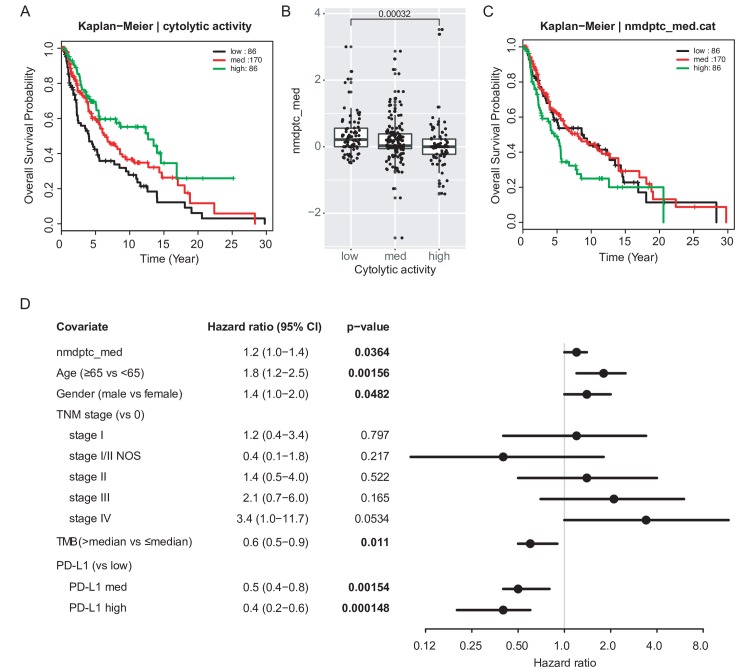
Cytolytic activity and NMD burden stratifies overall survival outcomes.(A) Kaplan-Meier overall survival for SKCM, stratified by cytolytic activity (categorized into low, med, and high based on quartiles). Legend shows the number of patients in each cytolytic activity level. (B) Association of feature nmdptc_med (NMD burden based on nonsense and frameshift, calculated based on median) on cytolytic activity. Statistical significance was determined using Mann-Whitney test. (C) Kaplan-Meier overall survival for SKCM, stratified by nmdptc_med (categorized into low, med, and high based on quartiles). (D) Forest plot of hazard ratios of each variable, in a multivariate Cox regression model for NMD burden (nmdptc_med), controlling for age, gender, TNM stage, tumor mutational burden (TMB), and PD-L1 levels.